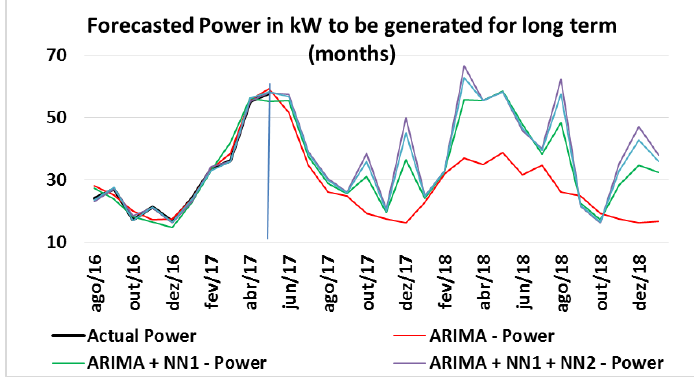
Figure 17. Predicted Power Generated for long Term forecast (months) in KW.